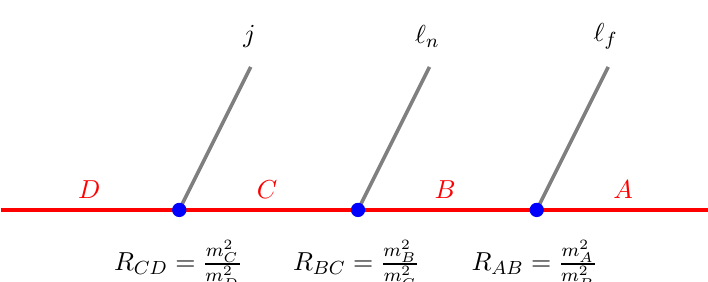
Figure 1 . The generic decay chain under consideration in this paper: D where A , B , C and D are new BSM particles, while the SM decay products consist of one jet j Figure 1: The typical cascade decay chain under consideration in this paper. Here D , C , B and and two leptons, labelled \near" ‘ n and \far" ‘ f . In the SUSY case, D represents a squark ~ q , A are new BSM particles, while the corresponding SM decay products are: a QCD jet j , a “near” C is a heavier neutralino ~ (cid:31) 0 , B is a charged slepton ~ ‘ and A is the lightest neutralino ~ (cid:31) 0 2 lepton ! ± and a “far” lepton ! ∓ . This chain is quite common in SUSY, with the identification D = ˜ q , escapes undetected. The masses of the BSM particles are denoted by m D , m C , m B and m A . The n f C = ˜ χ 0 , B = ˜ ! and A = ˜ χ 0 , where ˜ q is a squark, ˜ ! is a slepton, and ˜ χ 0 corresponding ratios of squared masses R CD , R BC and R AB are introduced for convenience in 2 1 lightest neutralino. In what follows we shall quote our results in terms of the D mass m D and the writing the kinematic endpoint formulas (2.4){(2.11) and delineating the relevant regions in the three dimensionless squared mass ratios R CD , R BC and R AB defined in eq. (1.6). mass parameter space (1.1) (see also eq. (2.3) and (cid:12)gure 2